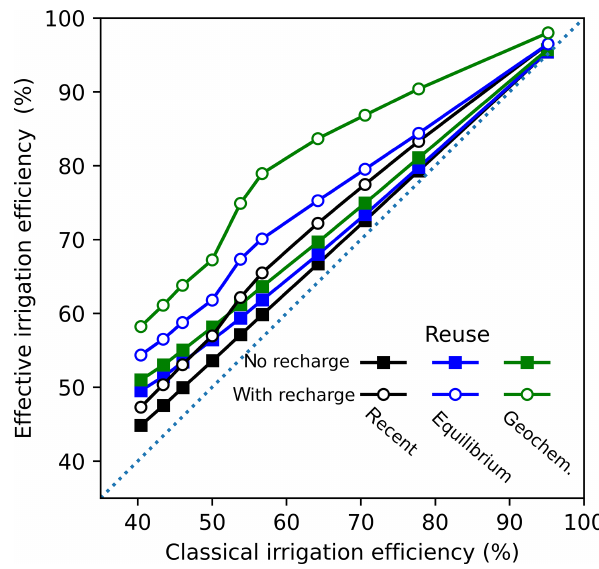
Figure 5. Effective irrigation efficiency plotted against the classical irrigation efficiency of each parameterization. Effective irrigation efficiency is calculated three ways based on the estimates of irriga- tion reuse as follows: near-term – simulated reuse, where incidental returns in aquifer abstractions are represented explicitly during the model epoch (3%); equilibrium – incidental returns in the aquifer abstractions are assumed to be at equilibrium in the aquifer at ratio of incidental recharge to total recharge (Table 2); and geochemical – incidental returns in aquifer abstractions are assumed to be rep- resented by an average estimated geochemically (Plummer et al., 2000;